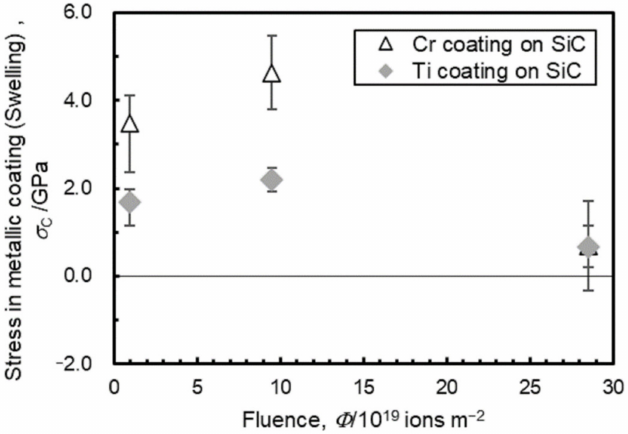
Figure 16. Simply estimated stress in pure Ti or Cr coating on CVD SiC after irradiation with 5.1 MeV Si 2+ ions up to a fluence of 2.85 × 10 20 ions/m 2 at 573